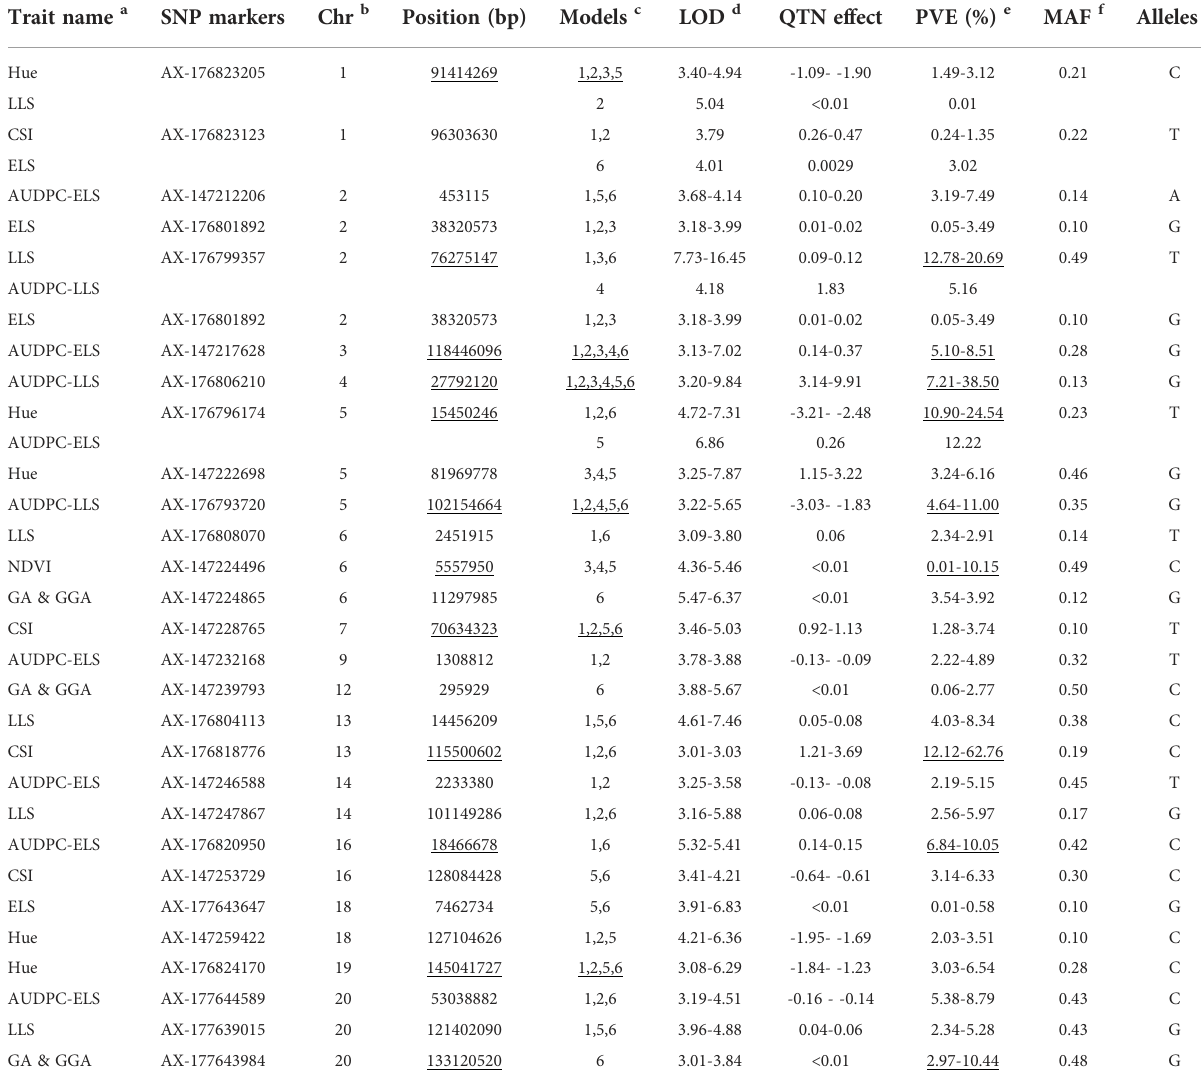
TABLE 4 SNPs detected by at least two of the six models for one or more traits. Trait name